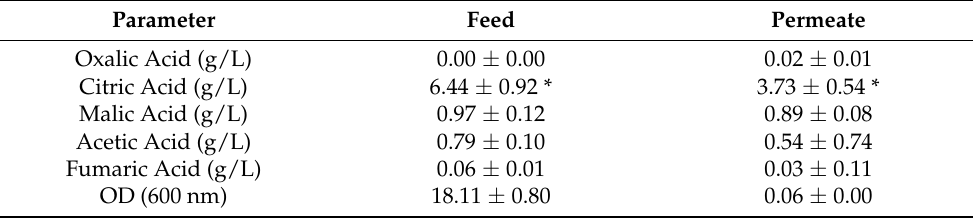
Table 5. Mean values of optical density (OD 600 ) and high-performance liquid chromatography (HPLC) results of the feed and permeate from the three fermentation broth filtration tests at t = 24 h. Parameter Feed Permeate Oxalic Acid (g/L) 0.00 ± 0.00 0.02 ± 0.01 Citric Acid (g/L) 6.44 ± 0.92 * 3.73 ± 0.54 * Malic Acid (g/L) 0.97 ± 0.12 0.89 ± 0.08 Acetic Acid (g/L) 0.79 ± 0.10 0.54 ± 0.74 Fumaric Acid (g/L) 0.06 ± 0.01 0.03 ± 0.11 OD (600 nm) 18.11 ± 0.80 0.06 ±